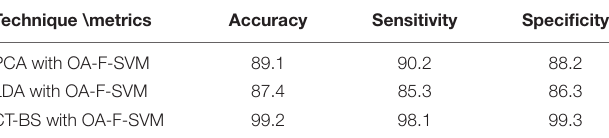
TABLE 9 | Classification rate based on different features reduction algorithms.